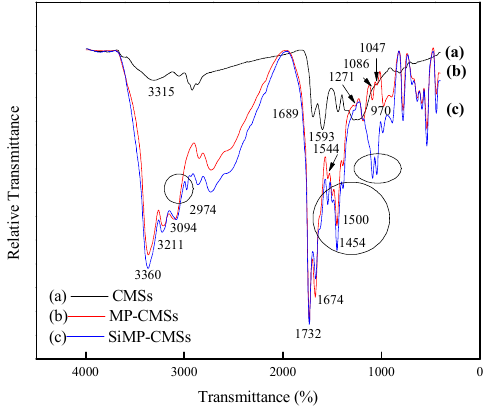
Figure 2. Fourier transformation infrared (FTIR) spectra of CMSs ( a ), MP-CMSs ( b ) and SiMP-CMSs ( c ).